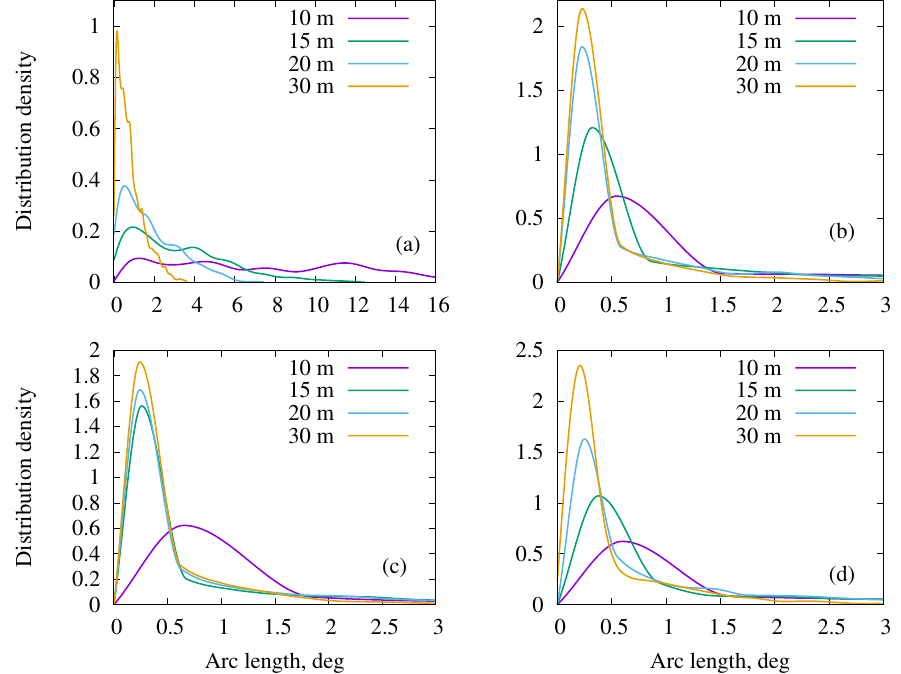
Figure 6. Distribution of open arc length a different distances in the spruce stand: ( a ) simulation; ( b ) Leica TLS measurements, 2013; ( c ) Leica TLS measurements, 2019; and ( d ) Trimble TLS measure- ments,